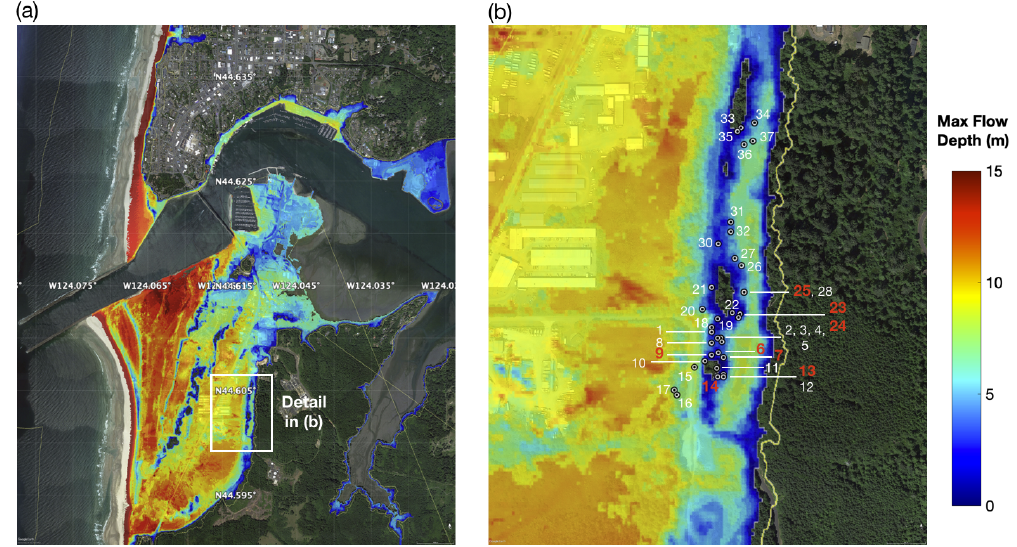
Figure 3. (a) Model of maximum tsunami inundation depth at South Beach for the L-sized earthquake 1700CE event; (b) zoom-in view of the tsunami inundation depth at Mike Miller State Park. Gray dotted circles show location of trees used in this study on the north side of the stand. Red numbers are the tree locations whose growth chronologies are shown in Fig. 4a and b. White numbers shows trees that were cored, but chronologies do not include the years before 1700CE. Colors on map show inundation depth from the model, implying 0–10m of inundation depth at the Mike Miller Park Douglas-fir stand. Green areas are high ground locations that show no inundation. The yellow line shows, for comparison, the model of maximum run-up height for the M w = 9 . 2 “XXLarge” earthquake scenario (Priest et al., 2013). Base maps made using © Google Earth